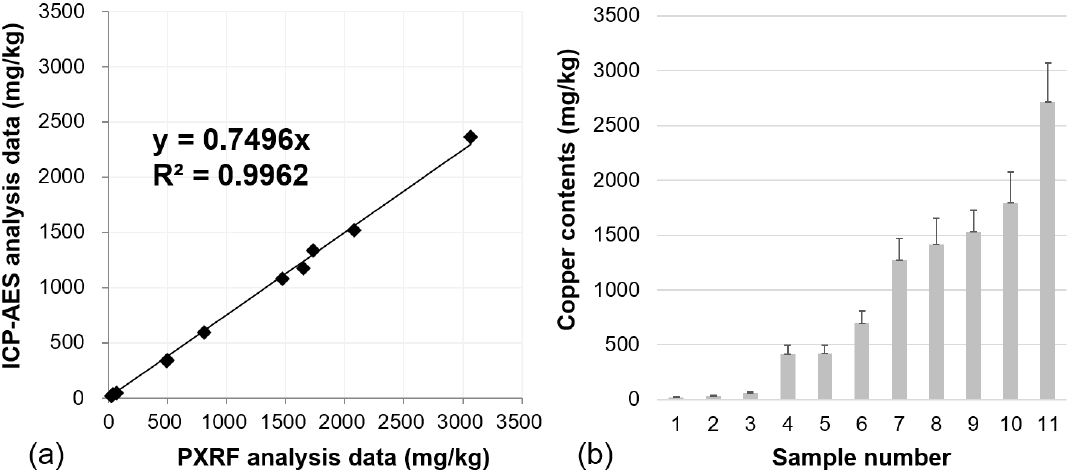
Figure 3. Plot showing the ( a ) Correlation between ICP-AES and PXRF values for Cu; ( b ) Standard deviation of the copper concentration in each point.